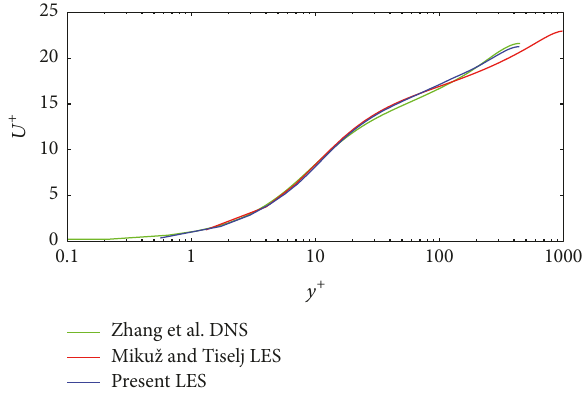
Figure 5: The streamwise velocity profiles in nondimensional